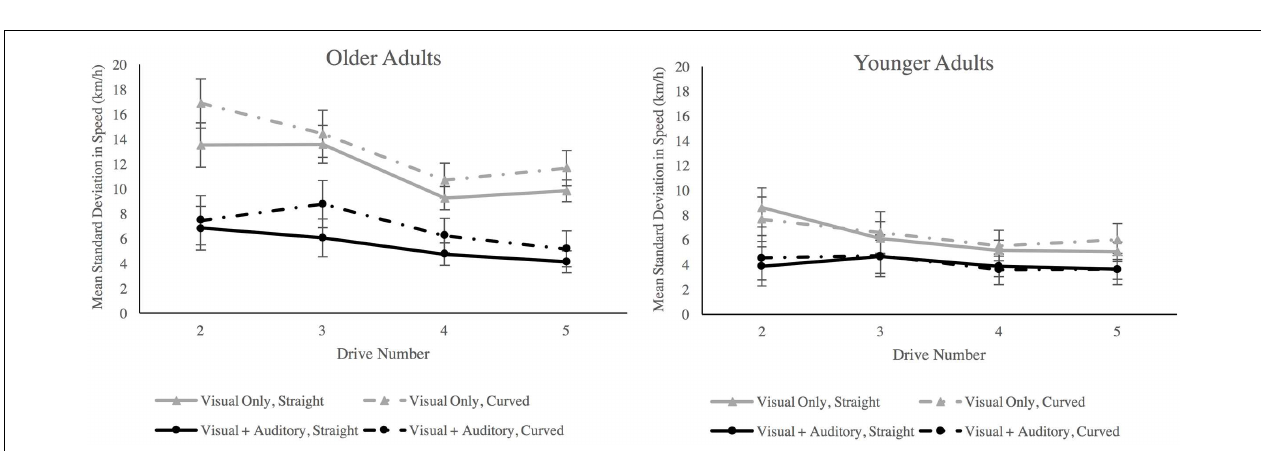
FIGURE 3 | Mean speed separated by age group, sensory condition, road geometry, and drive number. Error bars are + 1SE. There were significant main effects of age group and of road geometry. Participants drove faster in drives 3, 4, and 5 than in drive 2 but drove slower on curved segments than on straight segments overall. There was an age × sensory condition × road geometry interaction in which older adults in the visual only condition traversed curved road segments at a lower rate than straight road segments.